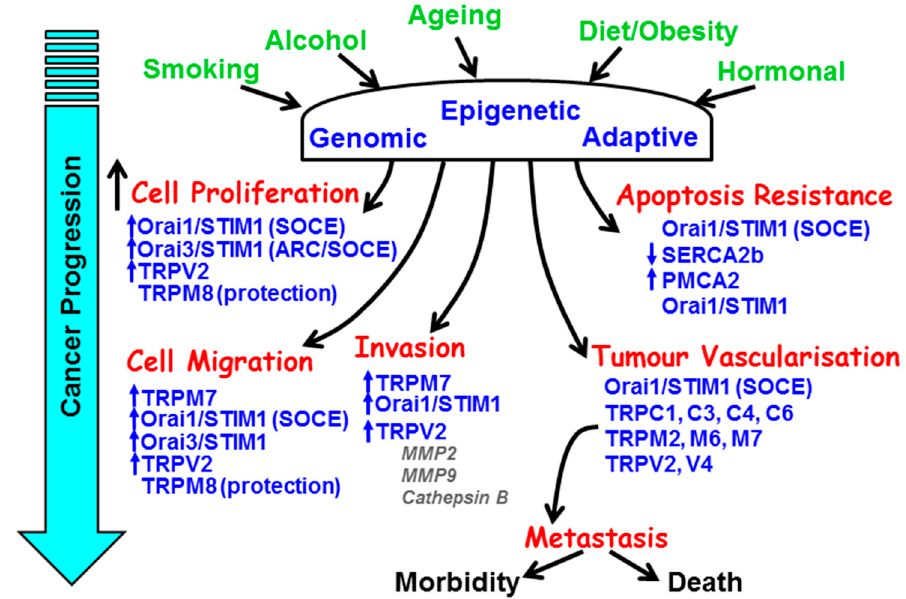
Figure 1. The remodelling of key components of the Ca 2 + signalling machinery responsible for the hallmark processes of cancer during cancer progression. The major causes and risk factors of cancer induce genomic, epigenetic, and adaptive changes in key Ca 2 + transporters responsible for the increase in cell proliferation, resistance to apoptosis, cellular migration and invasion, and tumour vascularisation.